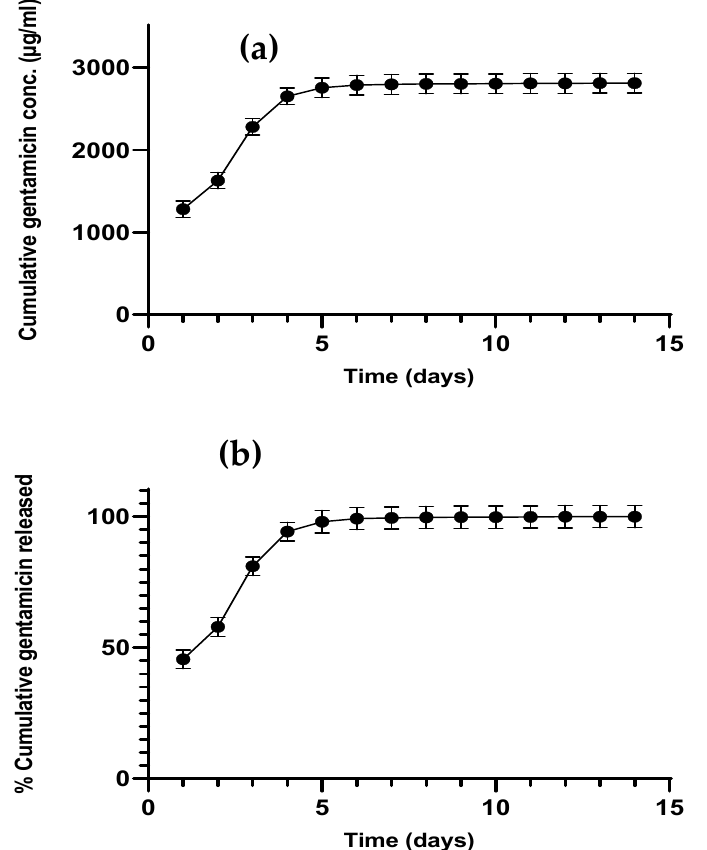
Figure 4. Gentamicin cumulative release in PBS media pH 7.4 from gentamicin-loaded CNT as concentration ( a ) or percentage release ( b ) ( n = 3 ± SD).